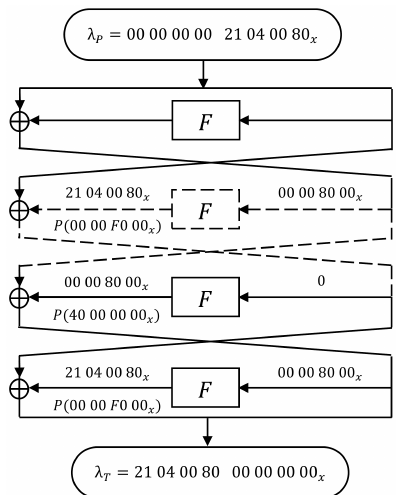
Figure 24: Four-Round Iterative Conditional Linear Approximation (the Concatenation of λ 13 and λ 14